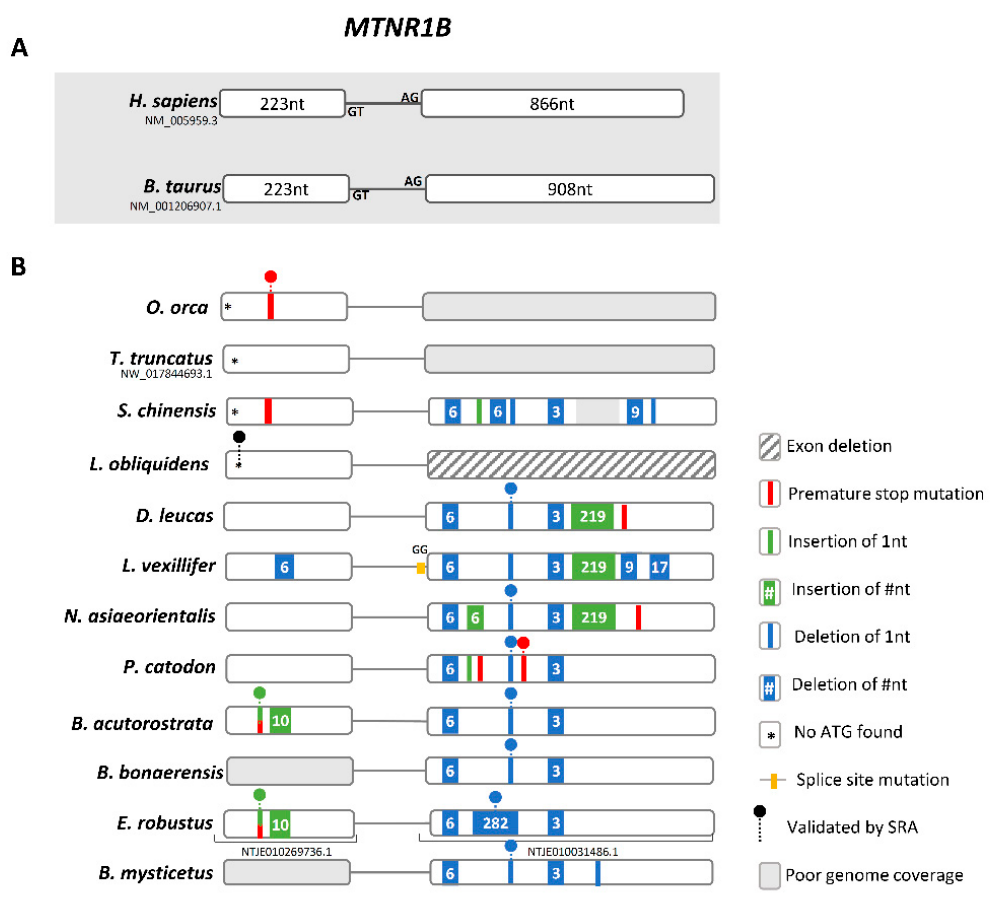
Figure 5. Mtnr1b gene annotation. ( A ) Schematic representation of the gene structure of human and B. taurus Mtnr1b gene (not to scale), each box represents an exon and lines represent intronic region. ( B ) Schematic representation of the corresponding Mtnr1b genes identified in Cetacea and location of the identified mutations. Non-canonical splice sites are indicated above the corresponding annotation.